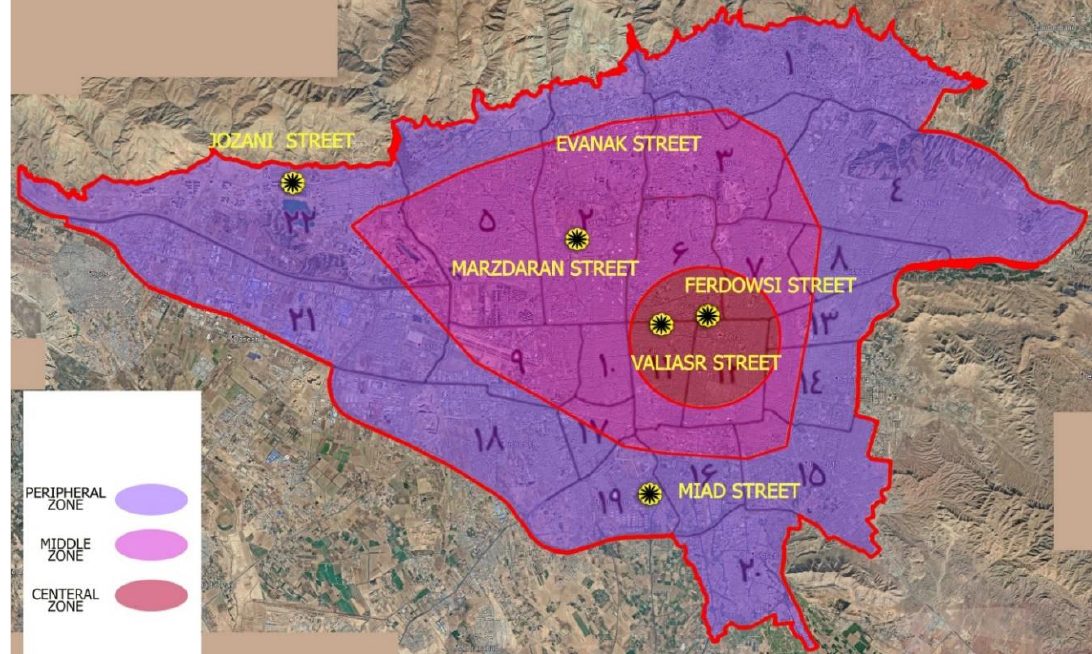
Figure 1. Locations of selected case studies for field studies (Source: Authors).